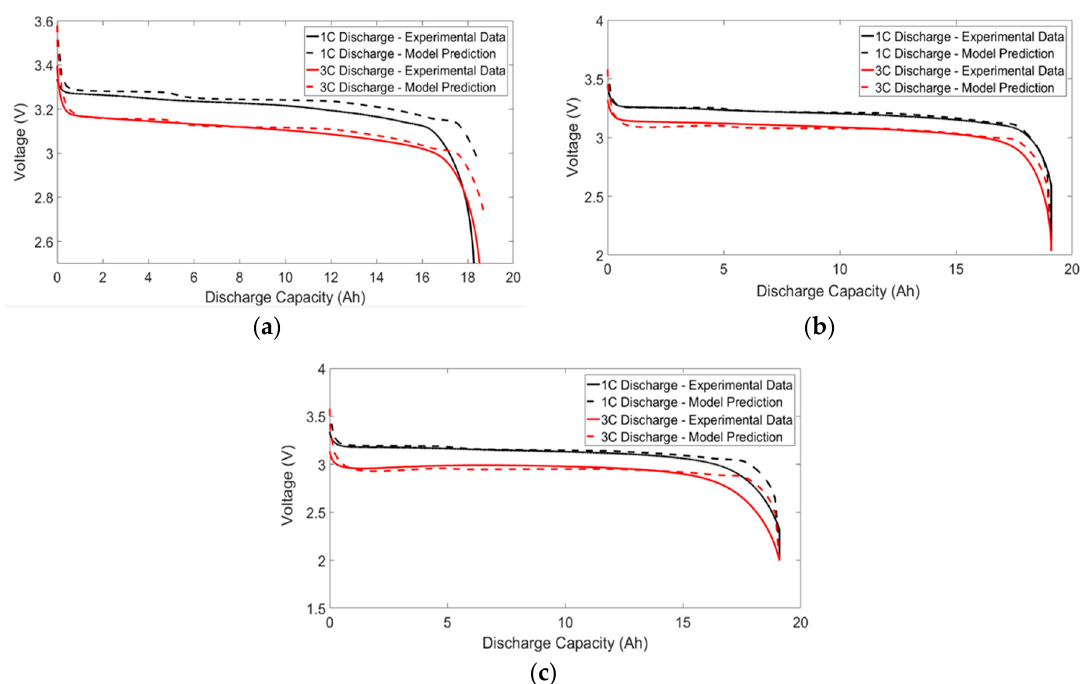
Figure 15. The predicted and simulated voltage profile at 1C and 2C/3C discharge for temperatures of: ( a ) 10 °C; ( b ) 25 °C; and ( c ) 40 °C.